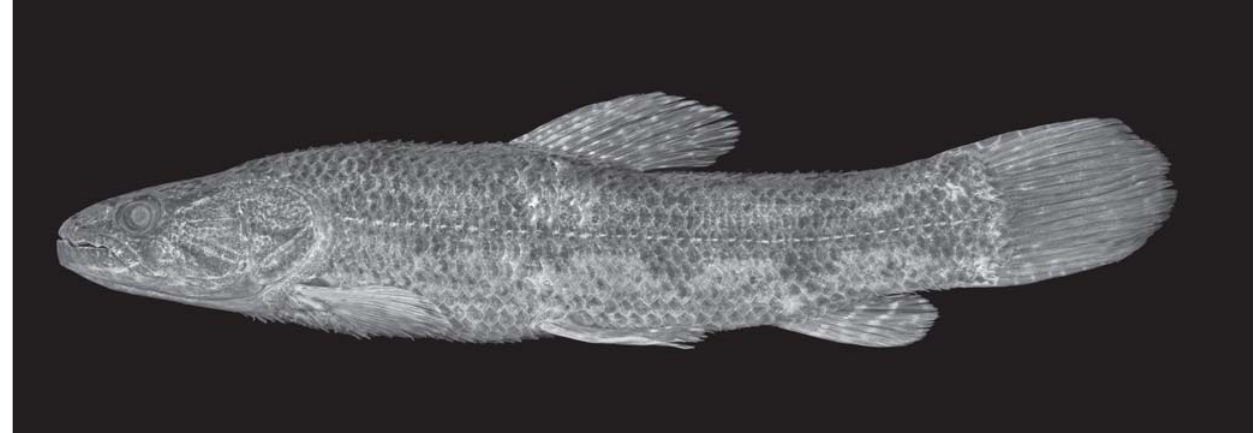
Fig. 8. Hoplias intermedius , MZUSP 69370, 169.3 mm SL, rio Suaçui Pequeno, Minas Gerais State,